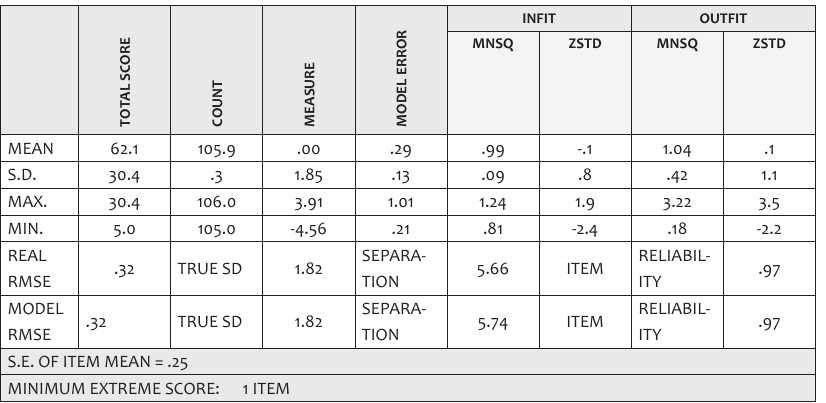
Table 1: Summary of 54 measured